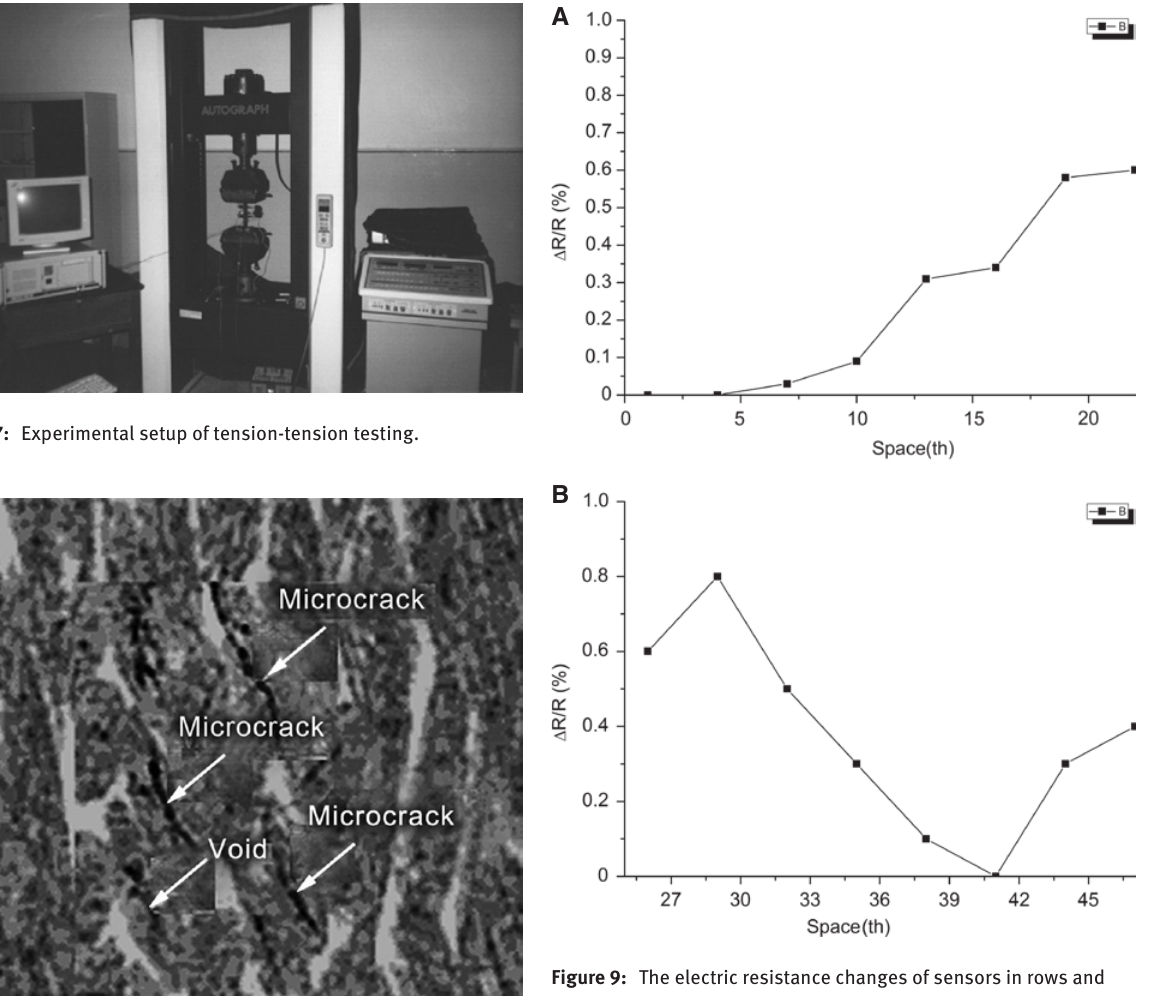
Figure 9: The electric resistance changes of sensors in rows and columns.